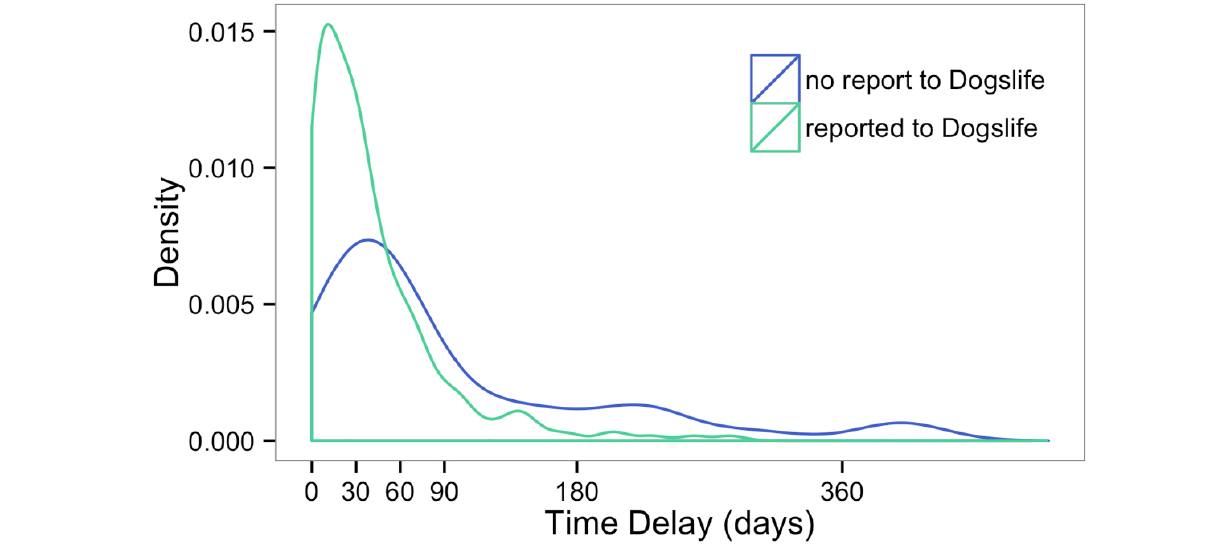
Figure 3. Vaccination recall decay plot (293 vaccinations, 127 dogs). Those not reported to Dogslife were vaccinations found in the veterinary record but omitted from the Dogslife questionnaire answers.